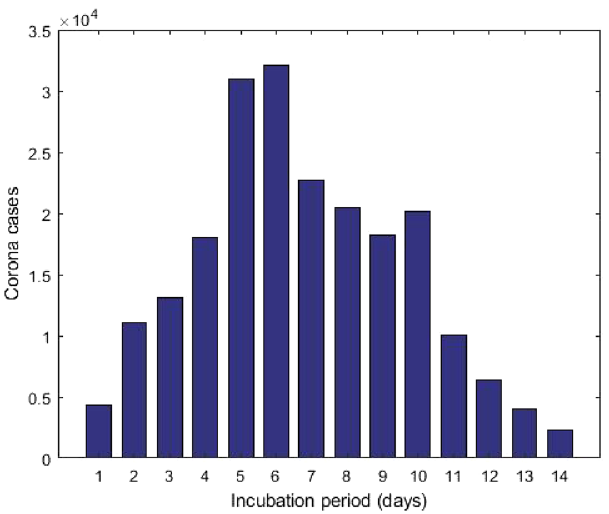
Figure 2. The cumulative data of confirmed corona cases as of October 23, 2020 is splitted into several incubation